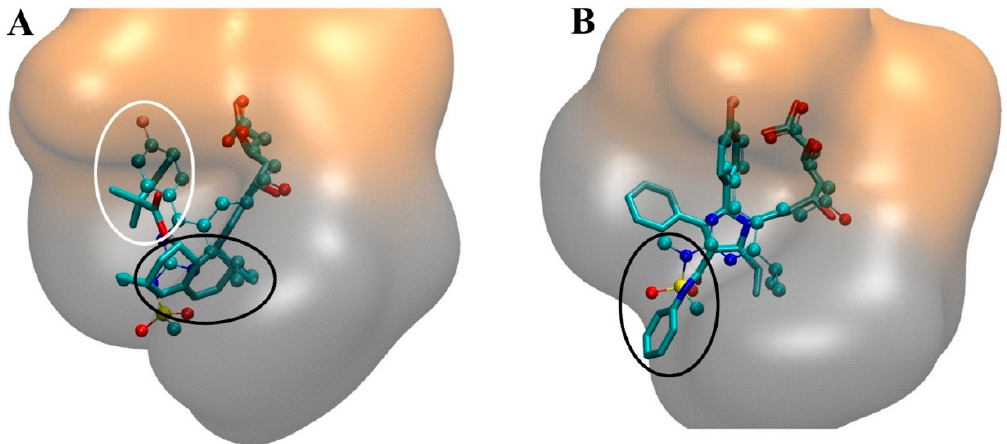
Figure 4. Binding of statins to HMGR ( A ) Overlay of Type I, simvastatin (stick) and Type II, rosuvastatin (ball and stick) in the HMGR binding site at the interface between two HMGR monomers (orange and grey) represented as a surface model. The binding site was defined by any HMGR residues within 4Å of any atom of a statin molecule. Circled in black is the common binding region of the naphthalene ring (Type I) and isopropyl (Type II). Circled in white is the common binding region of the butyryl group (Type I) and fluorophenyl group (Type II). ( B ) Overlay of atorvastatin (stick) and rosuvastatin (ball and stick) at the HMGR binding site between two HMGR monomers (orange and grey) represented in a bubble surface model. Circled in black are the common binding region of a carbonyl group (atorvastatin) and a sulphonamide group (rosuvastatin). Both images were prepared with VMD [71] and the PDB structures 1HW9.pdb and 1HWL.pdb.